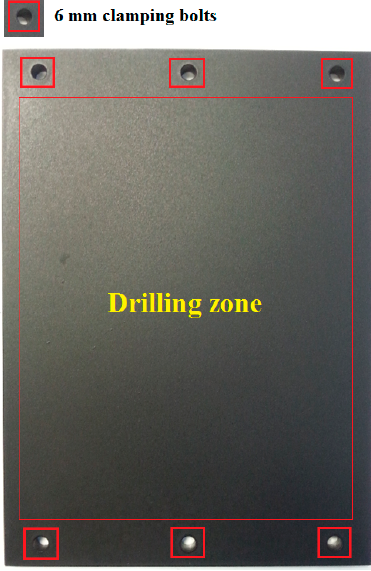
Figure 4. GLARE sample coated with black spray paint.